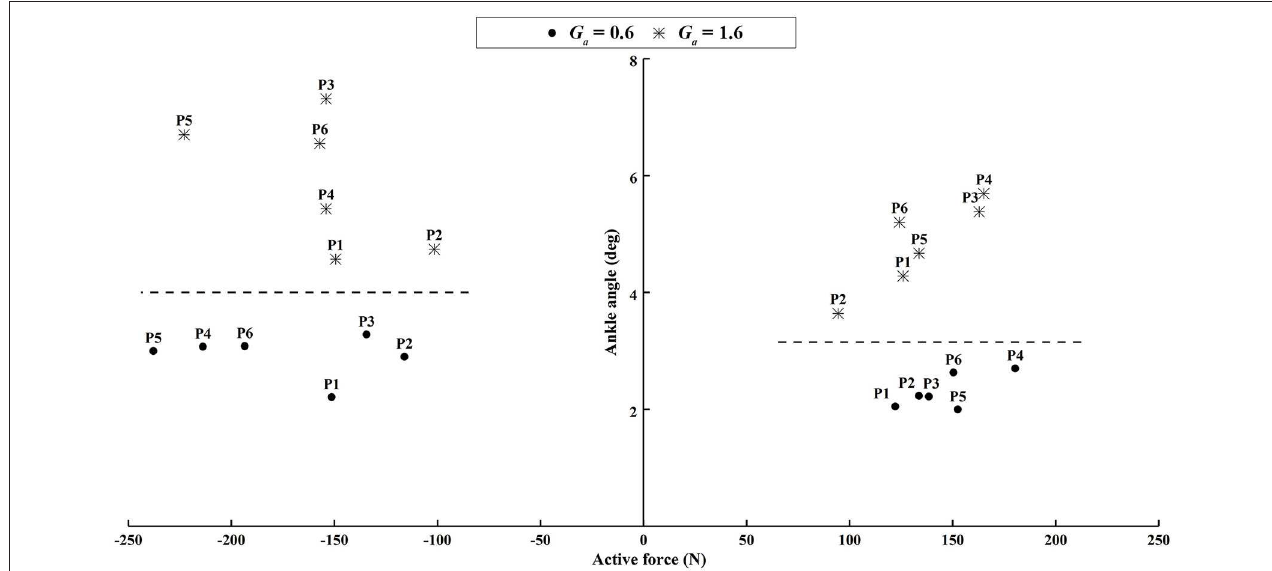
FIGURE 13 | The difference of the peak ankle angle between the experimental and passive simulated results produced by different active force. The left subplot shows the results when the participants voluntarily pushed down the foot within 60–80% of the gait cycle. The right subplot shows the results when the participants voluntarily lifted up the ankle joint within 30–60% of the gait